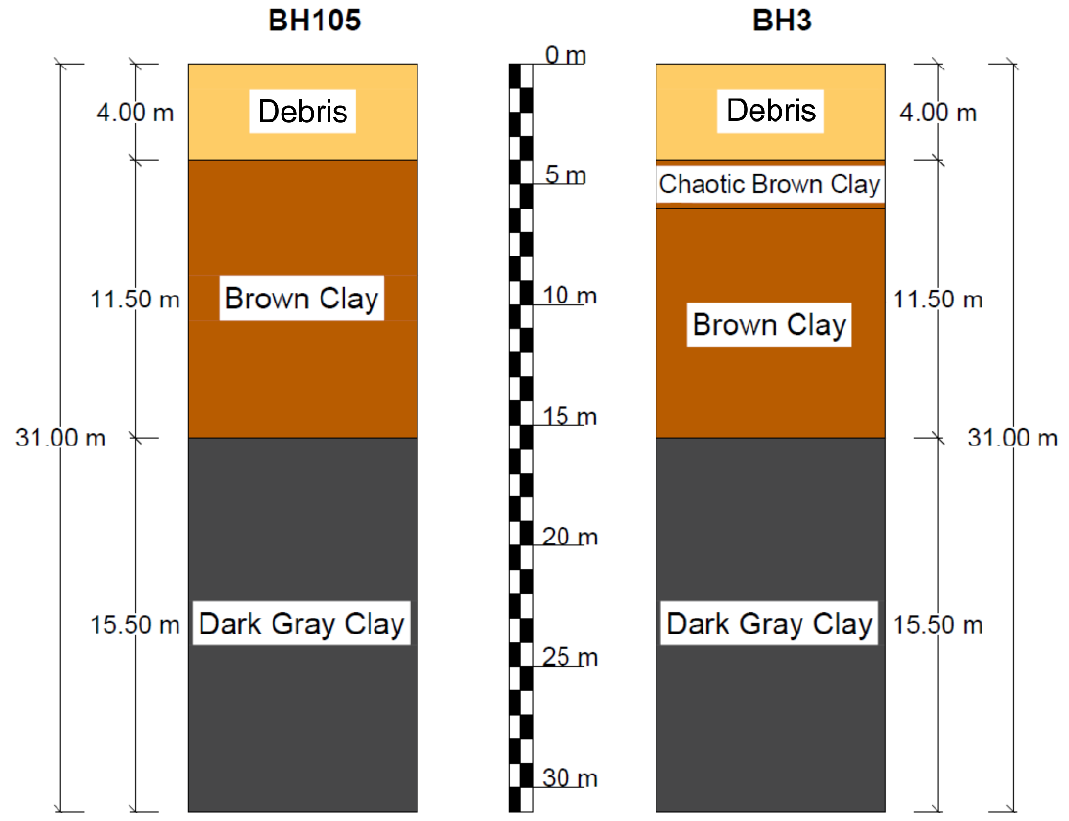
Figure 5. Soil profiles of S105 and S3 boreholes.